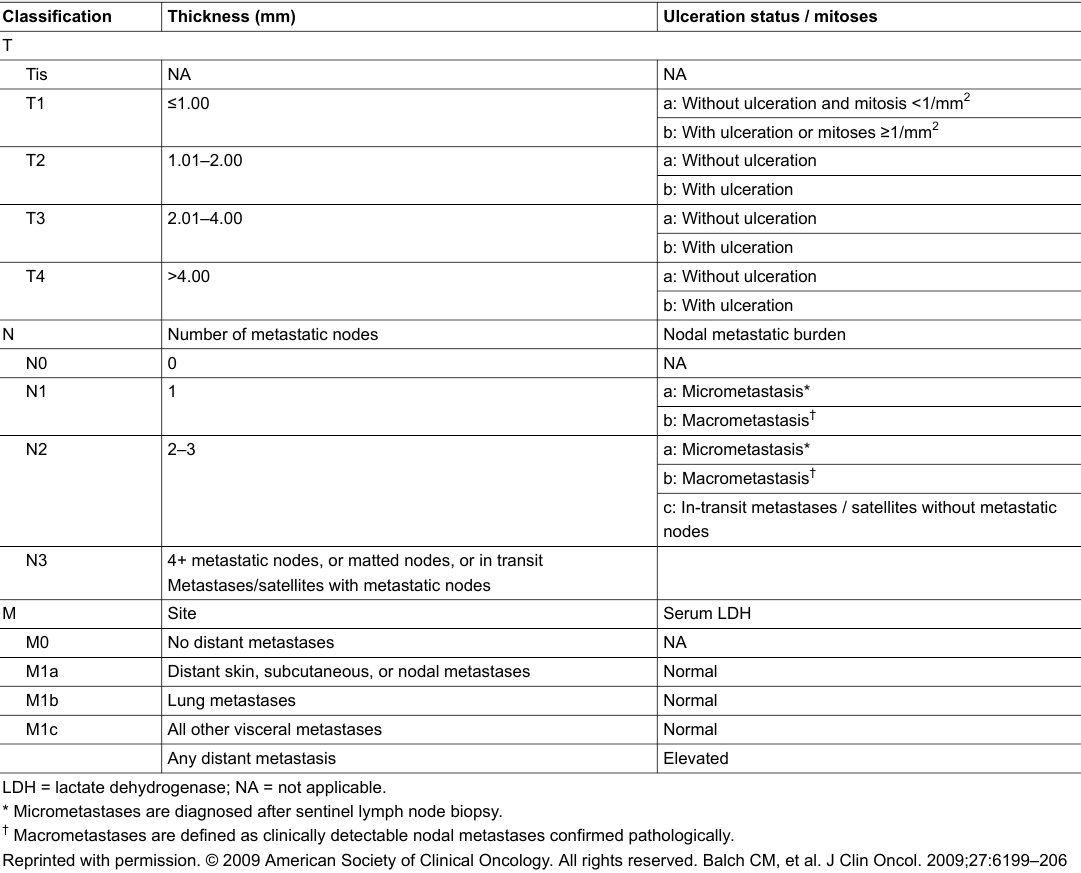
Table 1: The 2009 staging system for cutaneous melanoma according to the American Joint Committee on Cancer and Union for International Cancer Control [8, 9]. Reprint from: Balch CM, Gershenwald JE, Soong SJ, Thompson JF, Atkins MB, Byrd DR, et al. Final version of 2009 AJCC melanoma staging and classification. J Clin Oncol. 2009;27:6199–206, with permission from The American Society of Clinical Oncology.